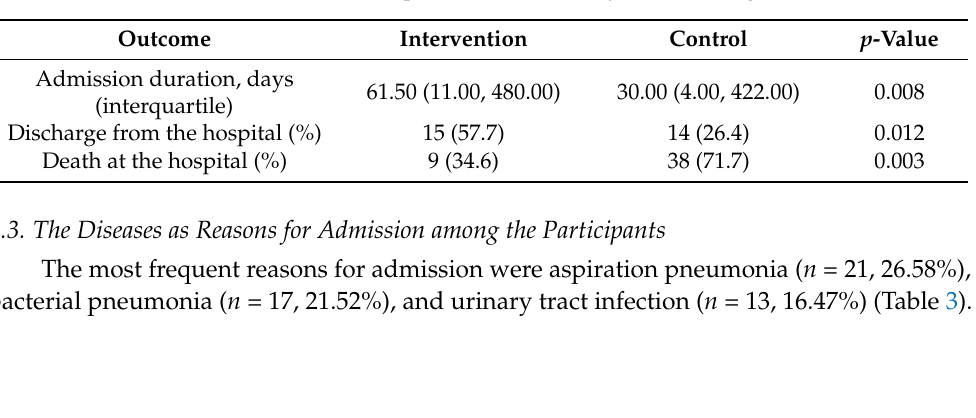
Table 2. Differences in the duration of hospitalization, mortality, and discharge